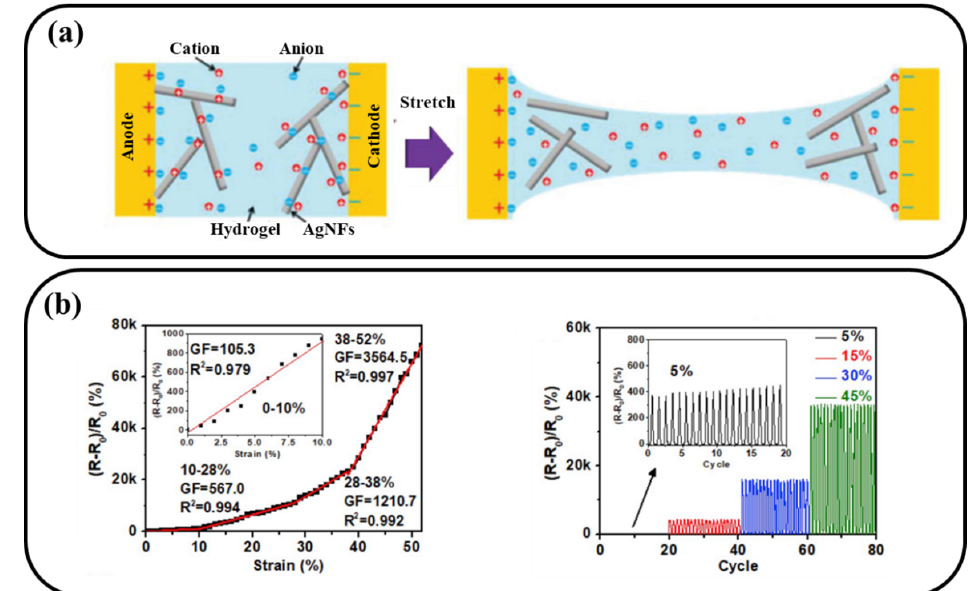
Figure 7. ( a ) Schematic of strain sensor based on brick-mortar structure, ( b ) Gauge factor and ( c ) Sensing behavior of strain sensor under different strain, respectively.